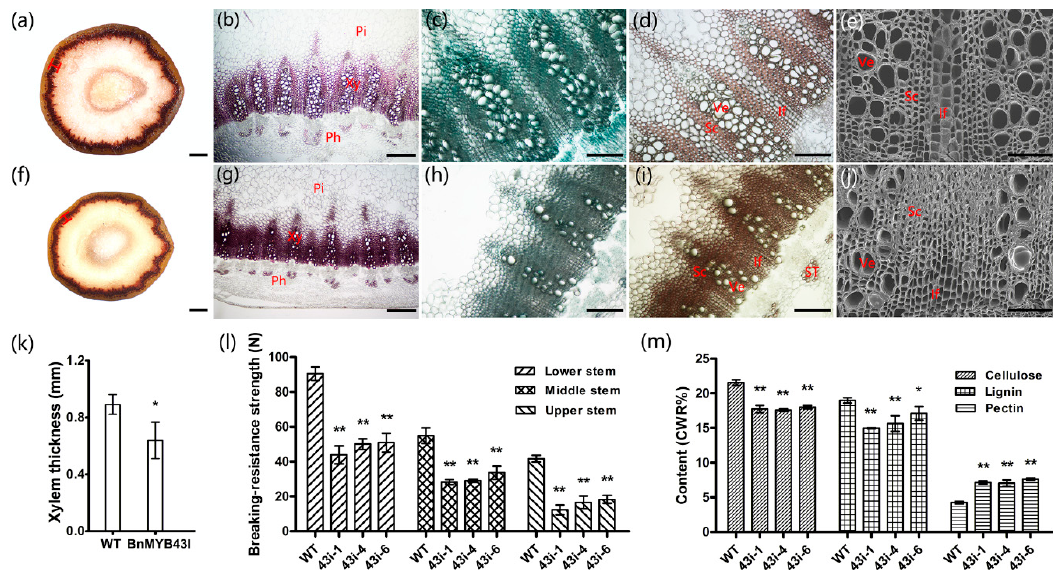
Figure 3. The phenotypes of morphologies, ingredients and properties of the stem in the oilseed rape at mature stage. ( a – e ) The cross sections of the stem in WT at mature stage. ( f – j ) The cross sections of the stem in the BnMYB43I lines at mature stage. ( a , f ) Mäule staining of lignin in whole cross sections. ( b , g ) Phloroglucinol-HCl staining of lignin in partial cross sections. ( c , h ) Fast Green FCF staining of cellulose in partial cross sections. ( d , i ) Hydroxylammonium staining of pectin in partial cross sections. ( e , j ) The morphologies of vessel and interfascicular fibers. ( k ) The thickness of xylem. ( l ) The breaking-resistance strength of stem. ( m ) Determination of the content of cellulose, lignin and pectin. Lengths of the I-line in ( a ) and ( f ) are the lengths of each vascular bundle, and the average of them is the thickness of xylem. Pi, pith; Xy, xylem; Ph, phloem; Ve, vessel; Sc, sclerenchymatous cell; If, interfascicular fibers; ST, sieve tube; Bar, 2 mm ( a,j ), 500 µm ( b,g ), 250 µm ( c–d , h–i ), 100 µm ( e,j ). Values are means ± SD from nine biologically independent repeats. Asterisks indicate significant or extremely significant differences from the control (*, 0.01 ≤ p < 0.05; **, p < 0.01) using one-way ANOVA.